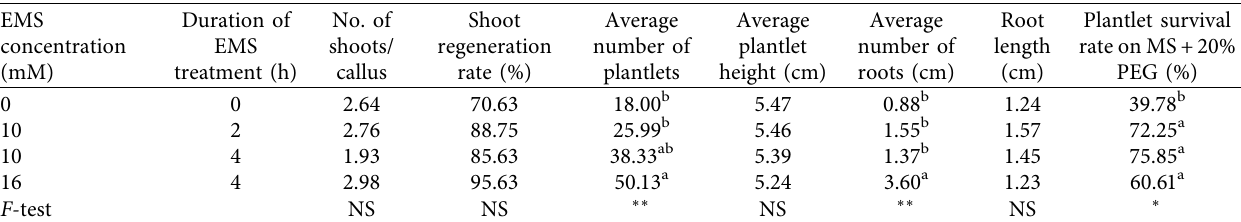
Figure 2: Weight of EMS-treated calli after culture on MS medium +20% PEG for 6 weeks. T 1: non-EMS-treated calli; T 2: calli treated with 10mM EMS for 2 h; T 3: calli treated with 10mM EMS for 4 h; and T 4: calli treated with 16mM EMS for 4h. Table 4: Regeneration rate and development of mutant sugarcane plantlets on regeneration media and survival rate of mutant sugarcane plantlets on selective medium with 20%